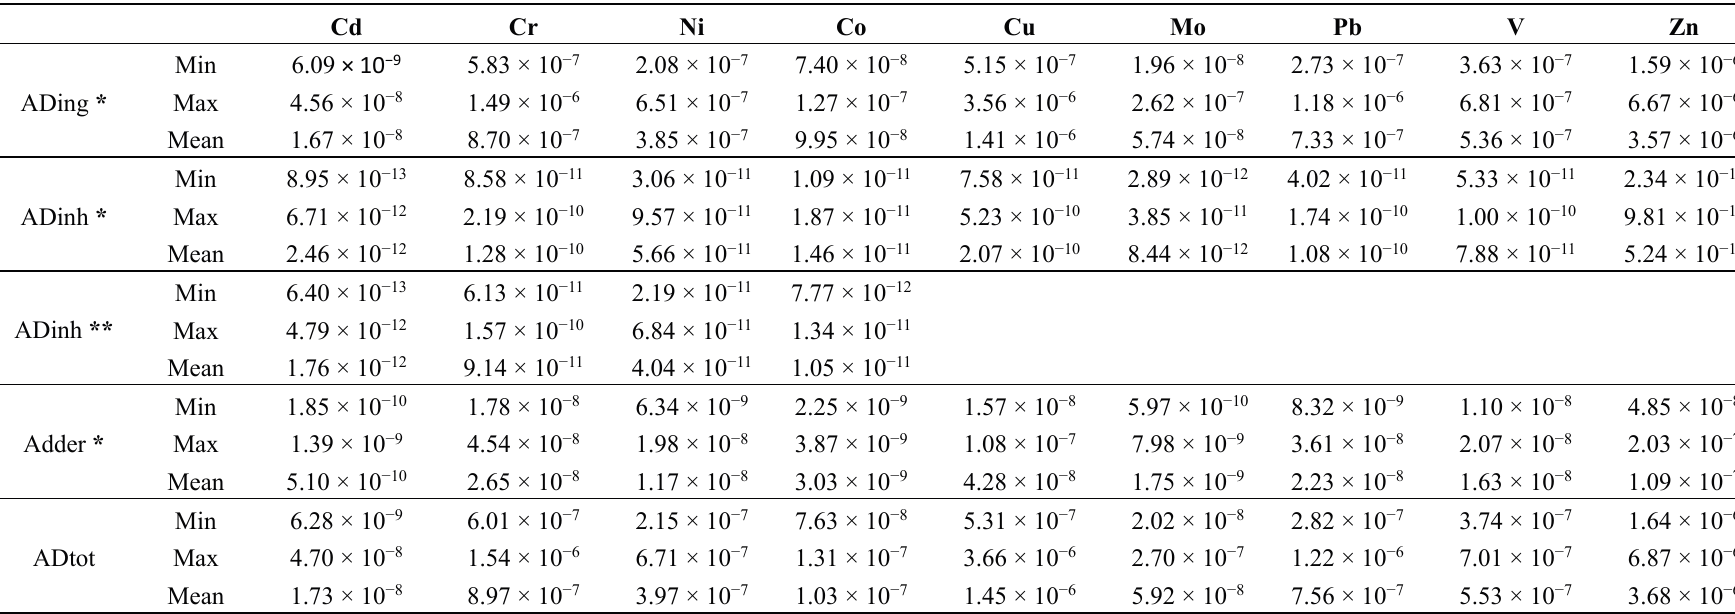
Table 4. Average daily exposure doses of metals in dustfall to adult (mg·kg − 1 ·day − 1 ). Cd Cr Ni